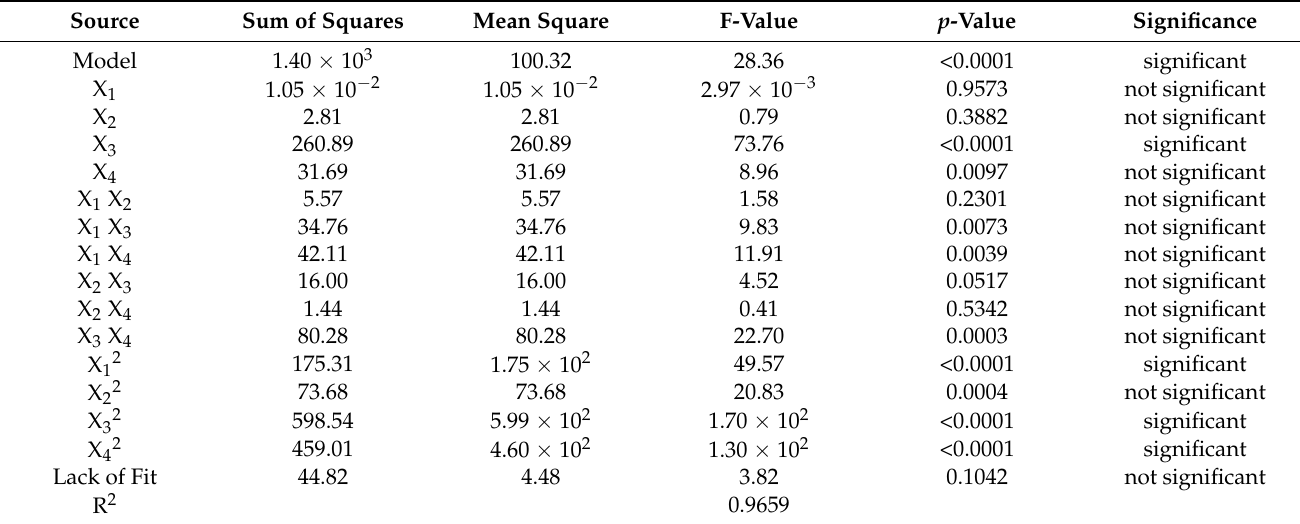
Table 4. Analysis of variance for the extraction yield of total flavonoids by quadratic